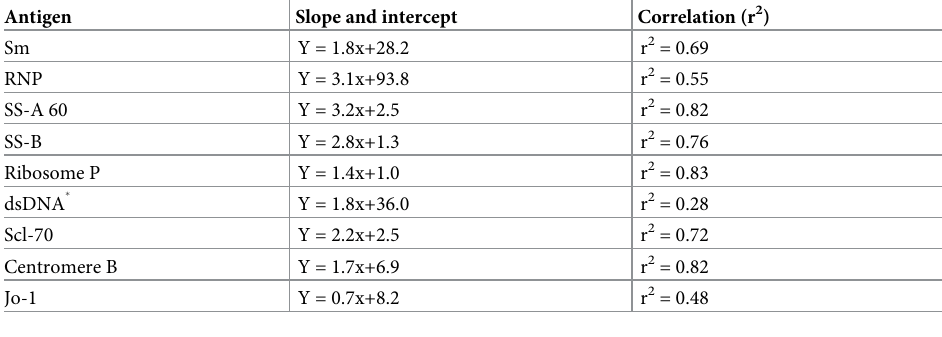
Table 2. Comparison of quantitative values from FIDIS.